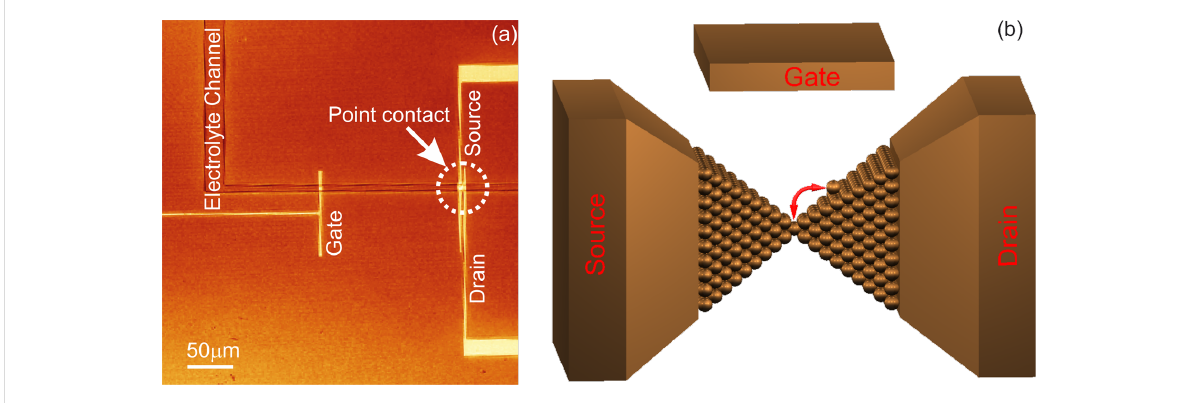
Figure 1: Copper atomic-scale transistor. (a) Confocal optical microscopy image of the microelectrodes, electrolyte channel and the copper point con- tact (indicated with a dotted circle), which was deposited between the source and the drain. (b) Schematic diagram of an atomic-scale transistor.